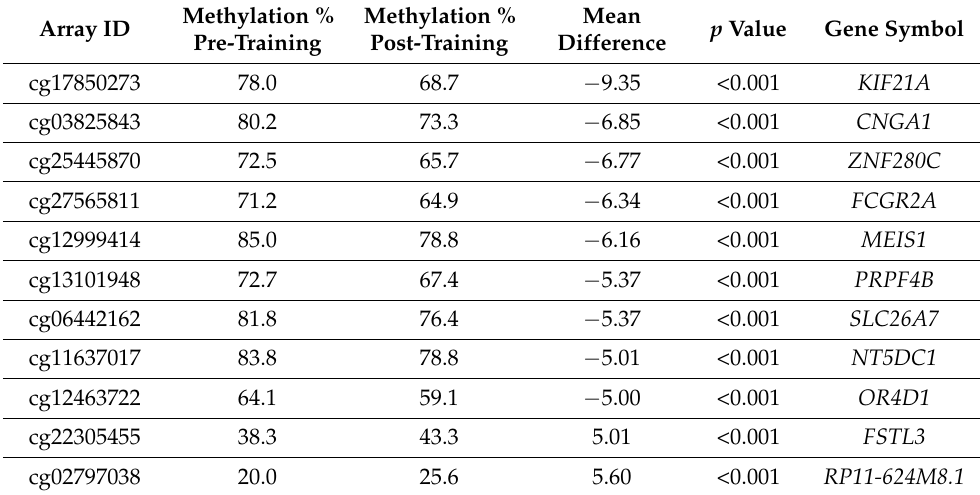
Table 3. Differentially methylated cytosines (DMCs, p < 0.001 and >5% change) following exer- cise